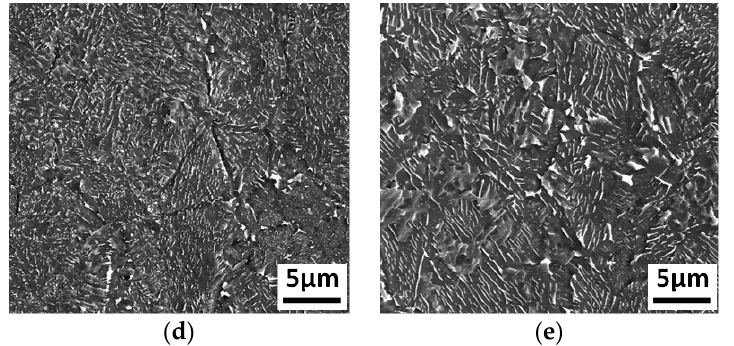
Figure 7. The Ti 3 Al LFW joint microstructures in the WZ after heat treatments at different temperatures: ( a ) after heat treatment at 700 °C, ( b ) after heat treatment at 750 °C, ( c ) after heat treatment at 800 °C, ( d ) after heat treatment at 850 °C, and ( e ) after heat treatment at 900 °C. The TMAZ of the as-welded joint was mainly composed of deformed α 2 phase and metastable structures. After heat treatment at 700 °C, the morphology of the residual deformed α 2 phase did not change significantly compared to that in the as-welded joint. The dot-like structures precipitated between α 2 phases, while short acicular structures appeared locally, as shown in Figure 8a. As the temperature increased, the size of the dot-like structures increased, while the size of the α 2 phase decreased, which was consistent with the variation in the dot-like structures inside the equiaxed grains at the center of the joint, as shown in Figure 8b. More specifically, at 800 °C, the morphology of the dot-like structure began to transform into short acicular structure, as shown in Figure 8c. It began to exhibit lamellar structure and the size of the α 2 phase decreased further at 850 °C, as shown in Figure 8d. The average length of lamellar structures is up to 5 μ m, as shown in Figure 8e.